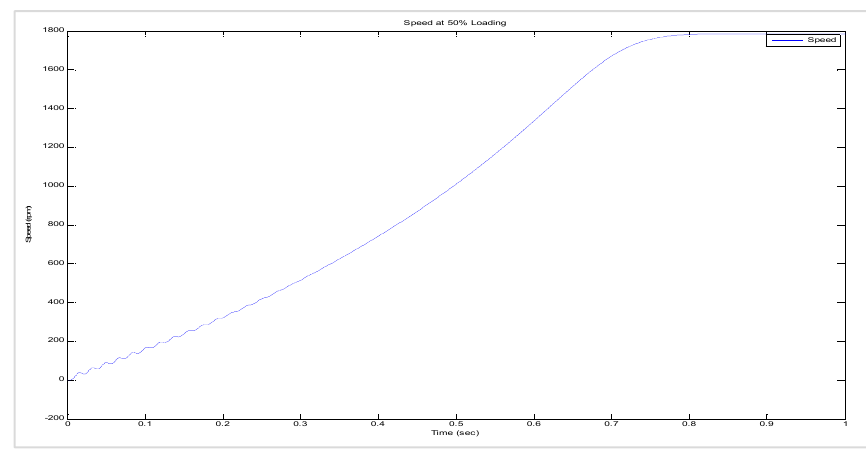
Figure 20. The speed at 50% loading.